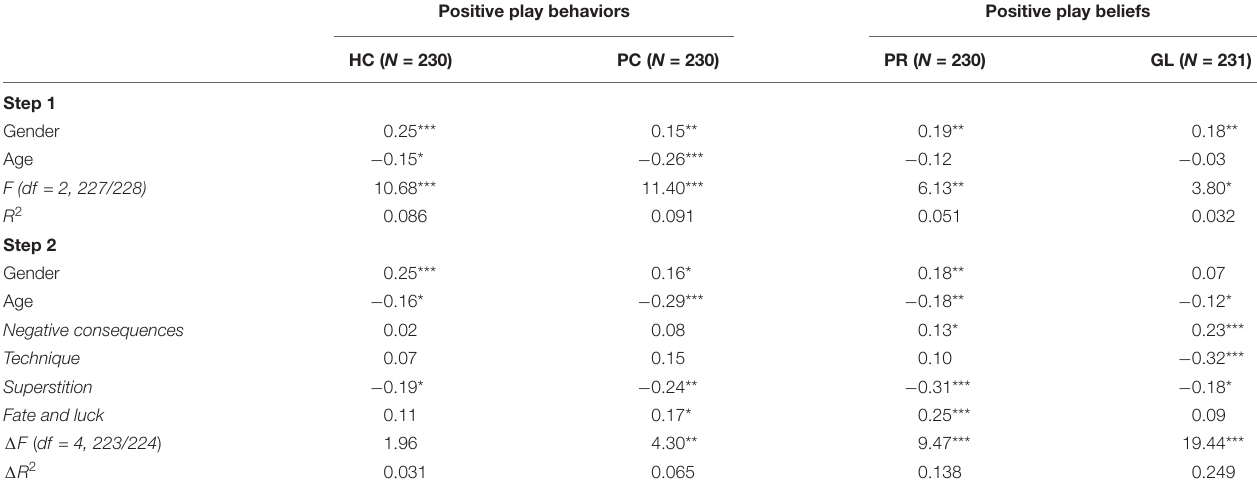
TABLE 5 | Hierarchical regressions of GMAB-R attitudes predicting PPS-AC